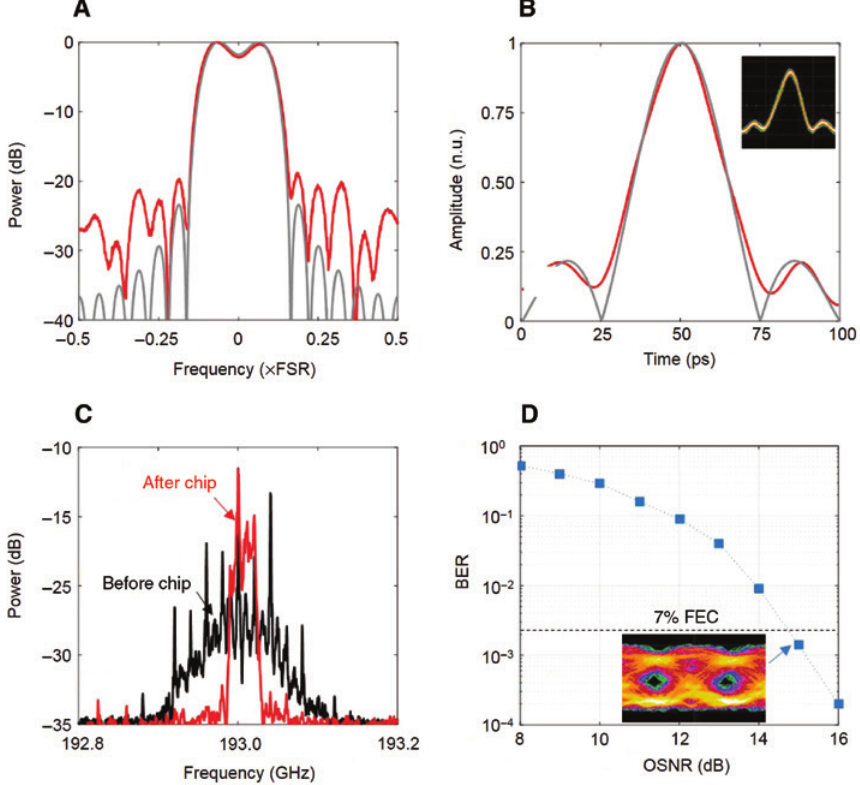
Figure 12: (A) Frequency response and (B) impulse response of the FIR filter. (C) Spectra of the modulated OTDM signal before and after the FIR filter. (D) BER measurements of the received on-off keying signals. Light-colored solid lines in Figure 12A and B are ideal spectra and impulse response,